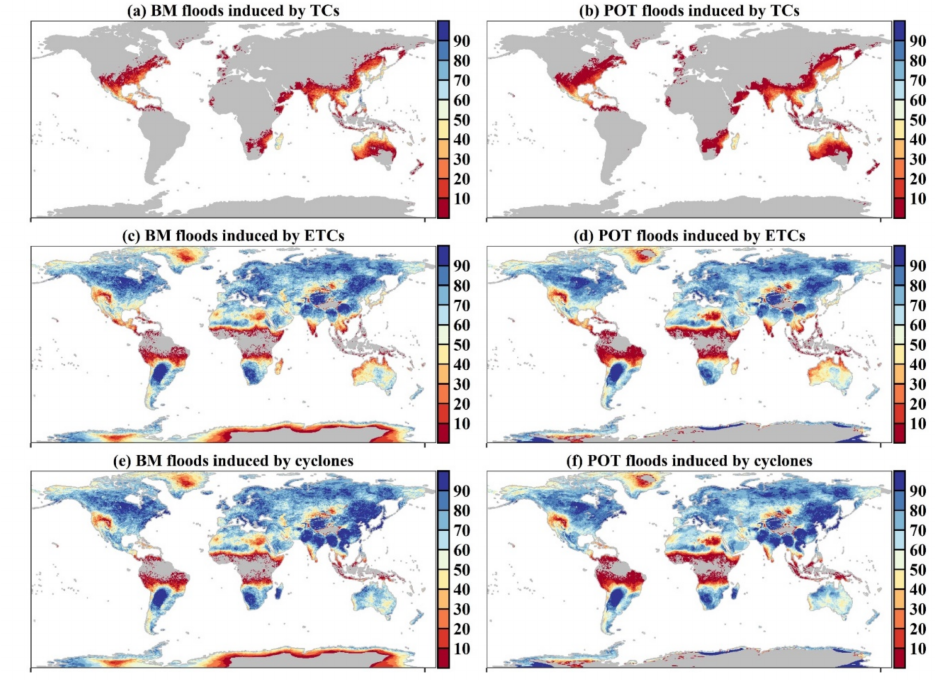
Figure 3. Contributions (%) of tropical cyclones (TCs), extratropical cyclones (ETCs), and all cyclones to annual floods in simulations sampled by block maximum (BM) ( a , c , e ) and peak-over-threshold (POT) ( b , d , f )